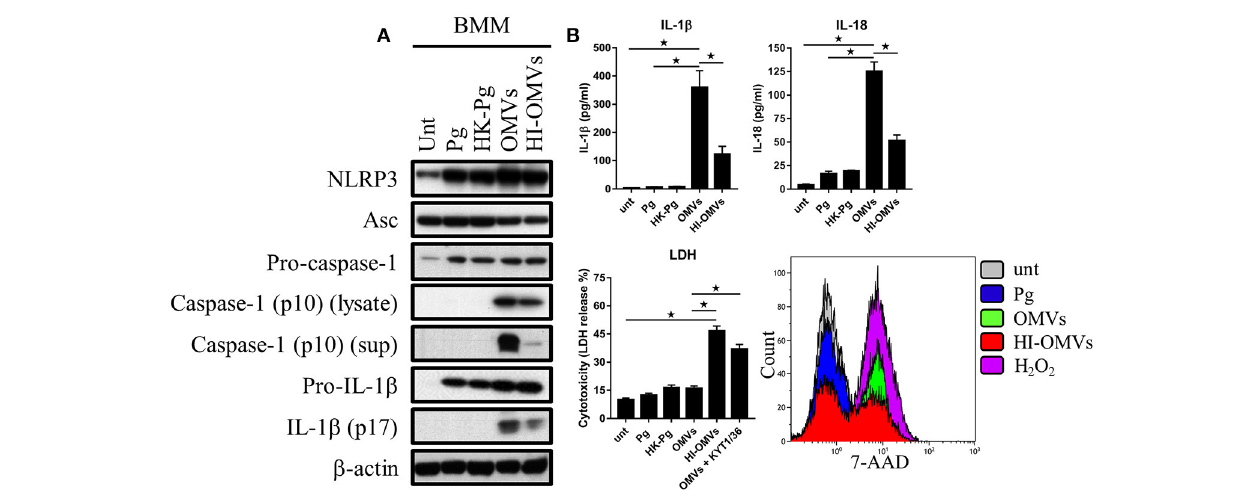
FIGURE 5 | P. gingivalis and its OMVs differentially induce inflammasome signaling and pyroptosis in murine macrophages. BMM were infected as before (2 h at MOI of 25:1, see Materials and Methods) with viable P. gingivalis ( Pg ), heat-killed- Pg (HK- Pg ), OMVs, or heat-inactivated-OMVs (HI-OMVs) and (A) the activation of inflammasome components in the lysates [or supernatants (sup) where indicated] measured after 24 h by Western blot; β -actin serves as a loading control throughout. Western blot data are representative of at least three independent experiments. (B) Production of IL-1 β and IL-18 (by ELISA) from BMM was measured in the supernatant at 24 h. Data are mean ± SD from four independent experiments. Cell viability was determined by measuring extracellular LDH release and by 7-AAD exclusion (by flow-cytometry) at 24 h. 7-AAD is a membrane impermeant dye that is excluded from viable cells. The percent of 7-AAD positive ( ± SD ) cells from three